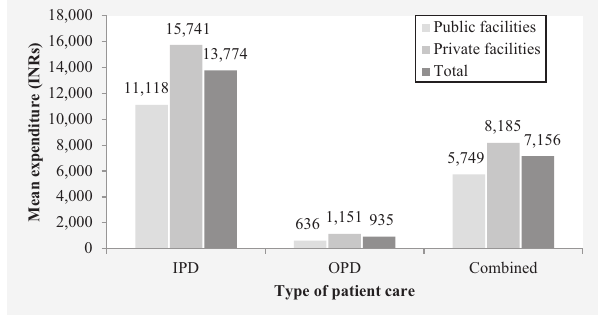
Figure 7. Mean out-of-pocket expenditure on